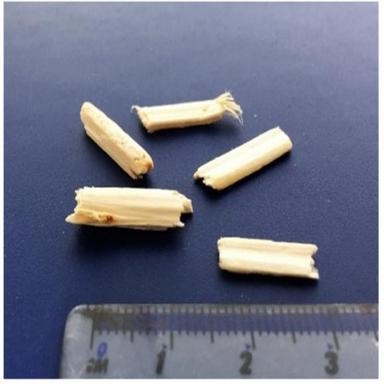
Hemp shiv aggregates used in this study. bly is shown in